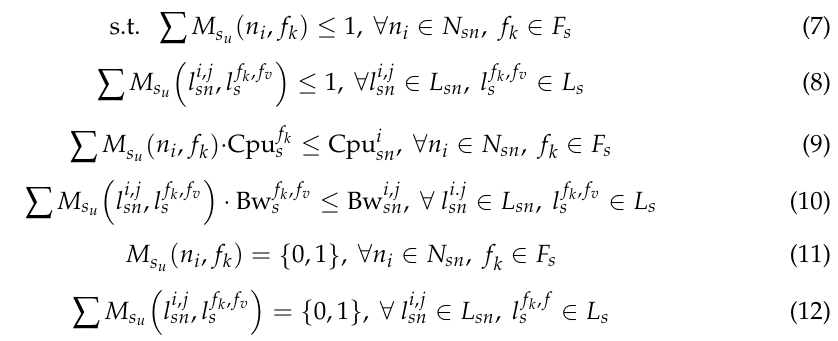
FQGA-SR algorithm